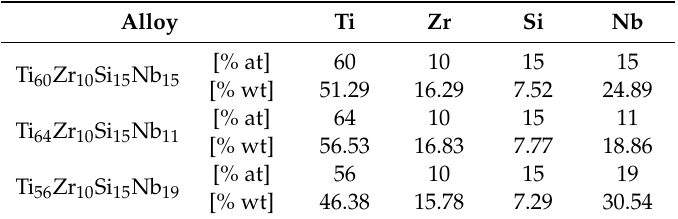
Table 1. Composition of Ti-based